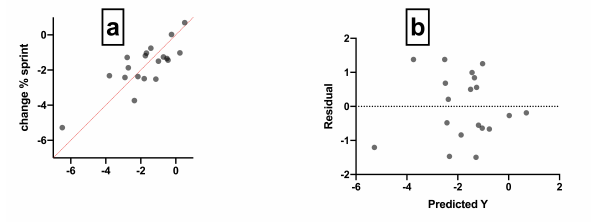
Fig. 3. Prediction of the percentage of change in (a) sprint and residual plots in (b) sprint of multiple linear regression analy- sis. Note: PHV, Peak height